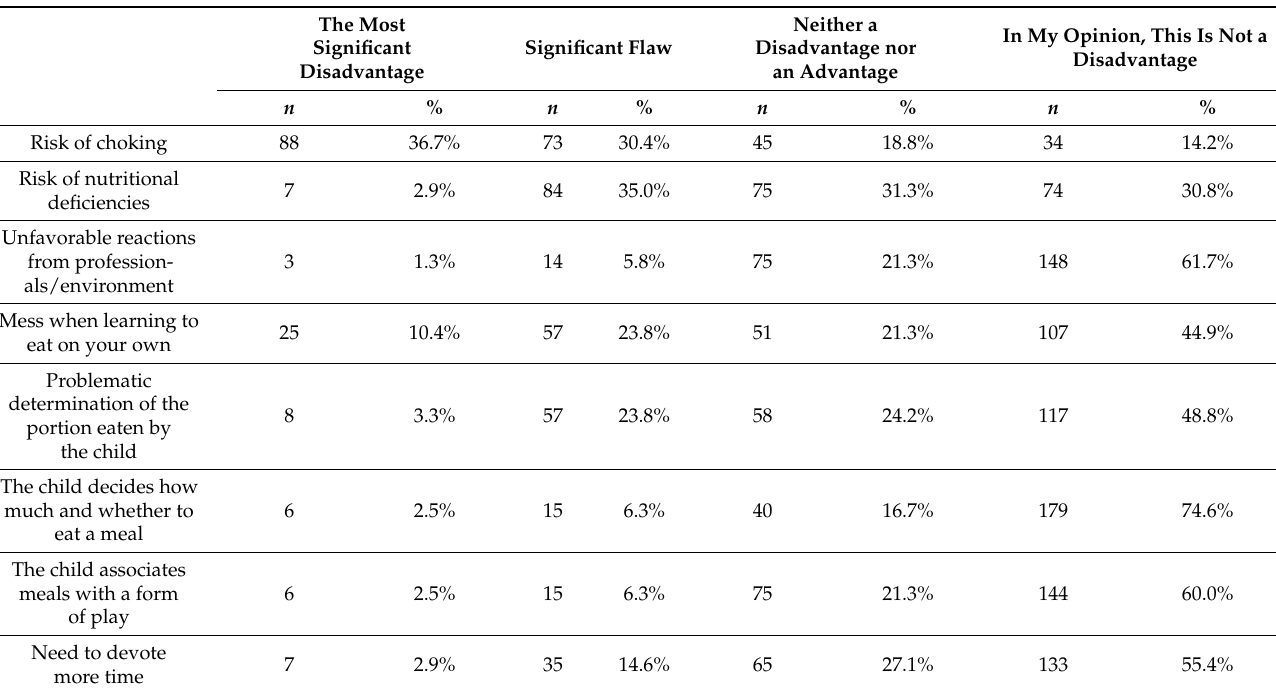
Table 6. Importance of BLW disadvantages in the group of mothers using BLW ( n =